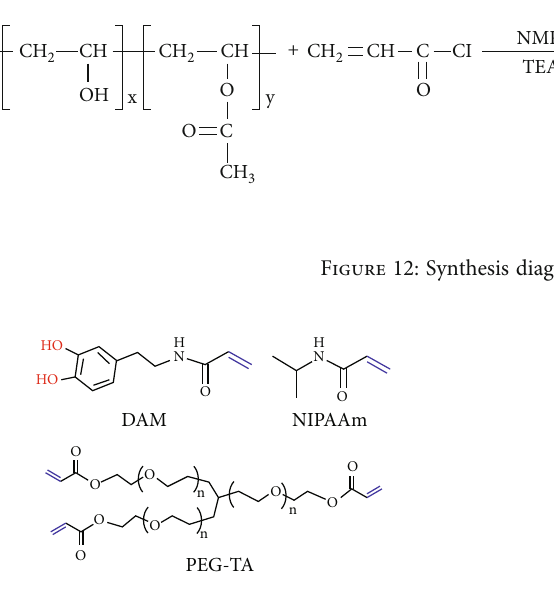
Figure 13: Chemical structure